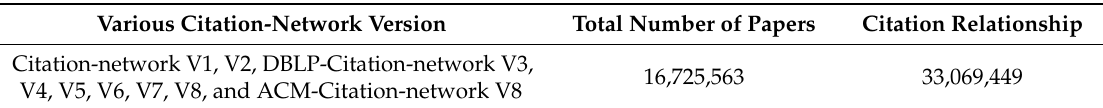
Table 5. Various citation-network version of 20